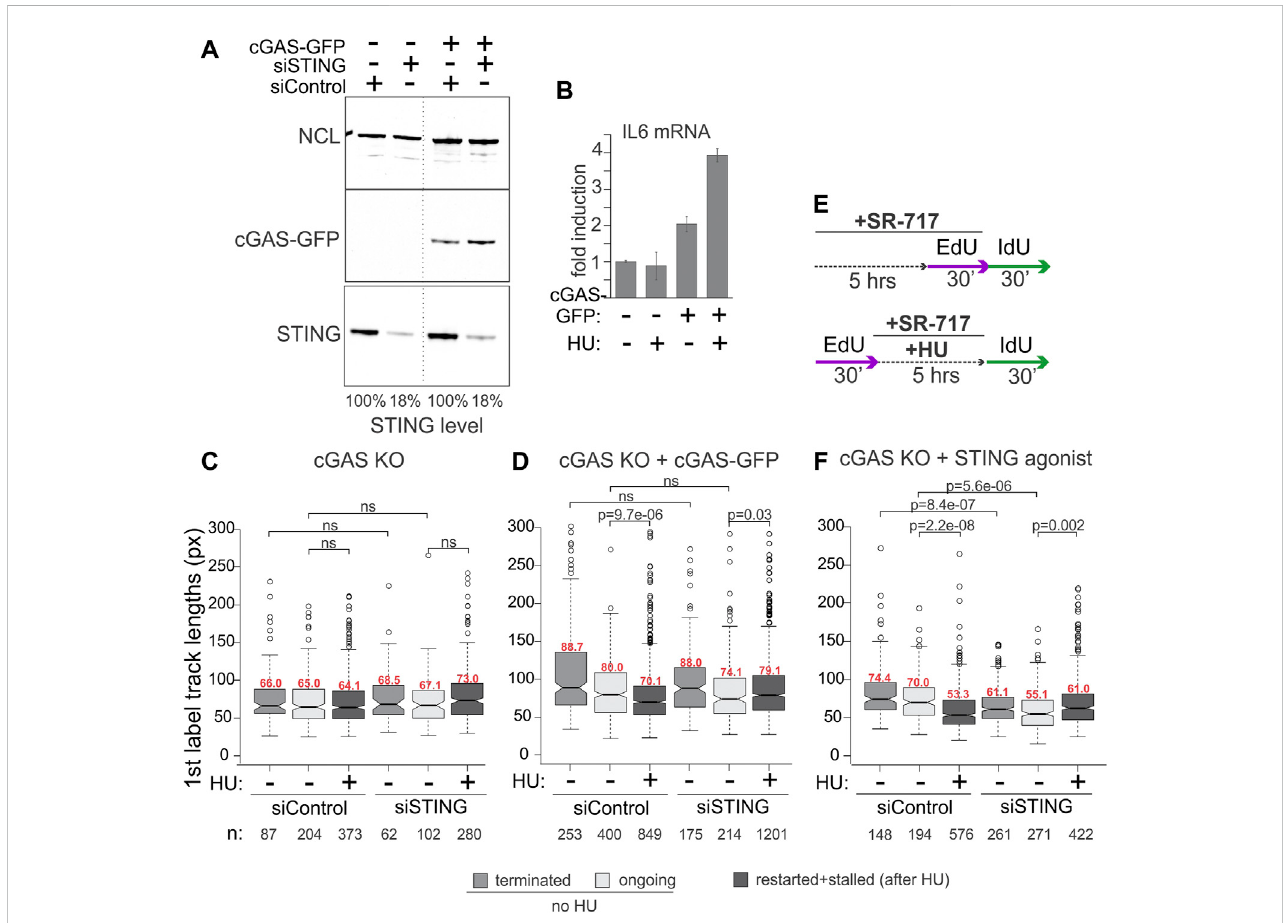
FIGURE 3 cGAS contributes to the activation of STING, which is required for STING effect on replication forks. (A) Depletion of STING and induction of cGAS-GFP expression in the cGAS knockout (KO) HeLa cells. Cells were transfected with the indicated siRNAs and in 24 h doxycycline was added to all cells (KO and complemented)at400 ng/ml for another 16 – 24 h.Adotted linemarksaspliced lane. (B) qPCRmeasurements of IL6 mRNA incGASKOandcGASKO/cGAS- GFPHeLaincubatedwith doxycyclineas in (A) toinduce cGAS-GFP, and treatedwith 5 mMHUfor 5 h.Error barsarestandarddeviations. (C,D) Boxplots of fi rst label (EdU) track length distributions in doxycycline-treated cGAS KO cells (C) and cGAS KO + cGAS-GFP cells (D) . The experimental design and HU treatment wasas inFigure 2, and track length values inrestarted and stalled forks after HU are combined due to thelow fraction ofrestarted forks. The results represent two independent experiments. (E) A modi fi cation to the experimental design to include a STING agonist SR-717 treatment. (F) Boxplots of fi rst label (EdU) track length distributions in cGAS KO cells with and without an incubation with SR-717 (4 μ M). The results represent two independent experiments.